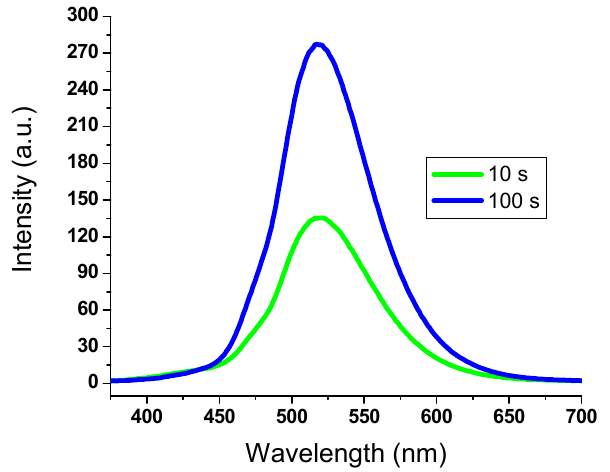
Figure 3. Excitation spectrum of S 8 .